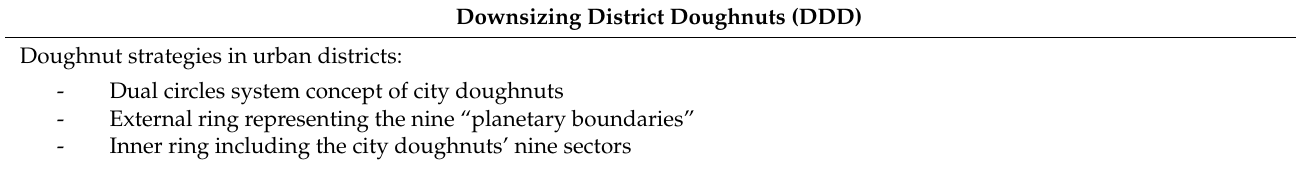
Table 2. The Downsizing District Doughnuts concept. Downsizing District Doughnuts